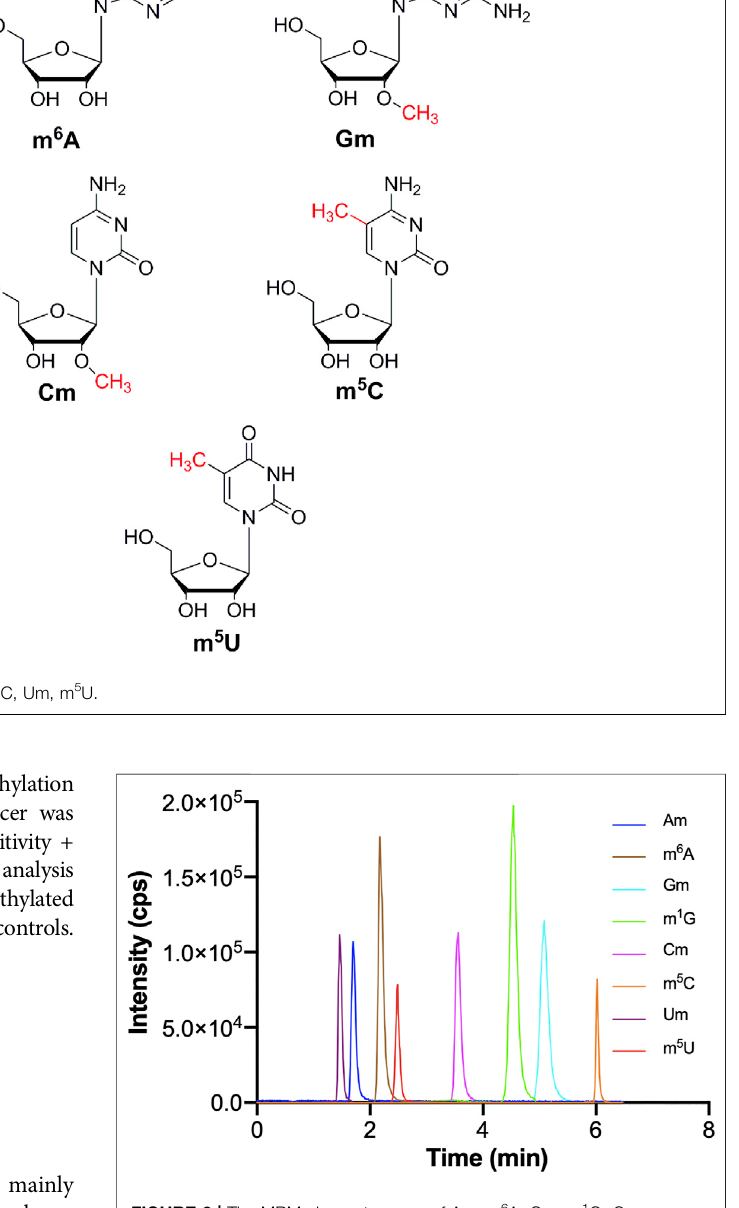
FIGURE 2 | The MRM chromatograms of Am, m 6 A, Gm, m 1 G, Cm, m 5 C, Um, m 5 U standards. The concentrations of Um and m 5 U were 1,000 nM, and the concentrations of other nucleosides standards were 100 nM. The injection volume was 5.0 μ